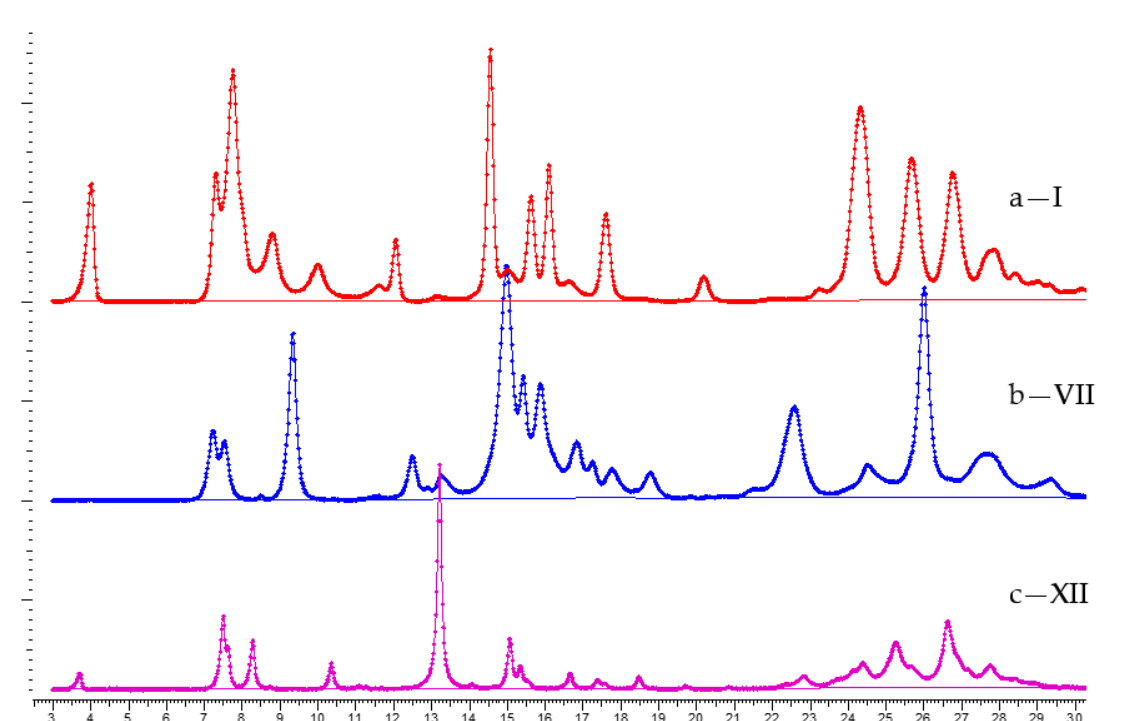
Figure 1. Raw X-ray powder diffraction (XRPD) data for unsolvated Eltrombopag free acid polymorphs (( a ) Form I; ( b ) Form VII, and ( c ) Form XII), in the low-angle (3–30° 2 θ ) range. x and y axes: 2 θ range, ° and intensities (a.u.), respectively. These raw data clearly demonstrate the higher crystallinity (narrower Bragg peaks) of Form XII ( c ) than for Form I ( a ) and Form VII ( b ).